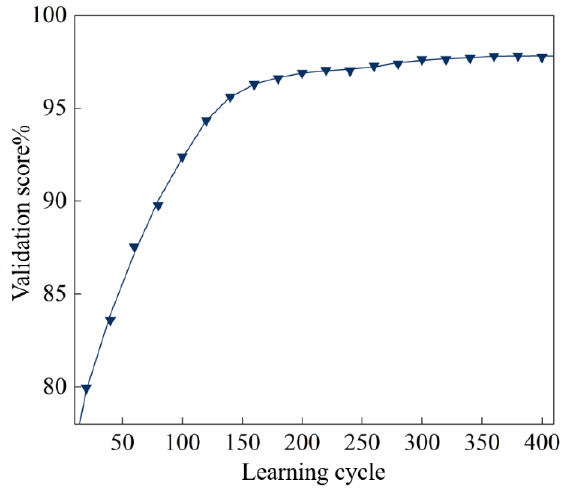
Figure 7. Relationship between learning cycle and the validation score.